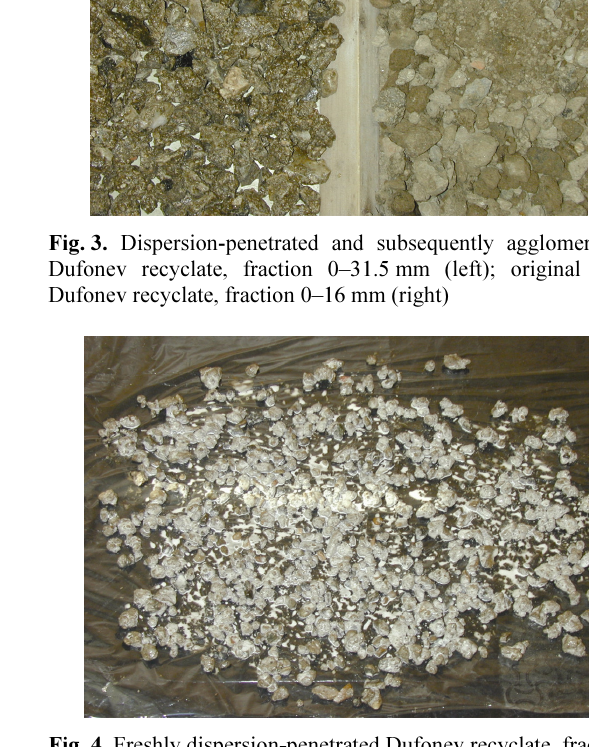
Fig. 4. Freshly dispersion - penetrated Dufonev recyclate, frac- tion 0–31.5 mm, spread to dry up and harden on a PE